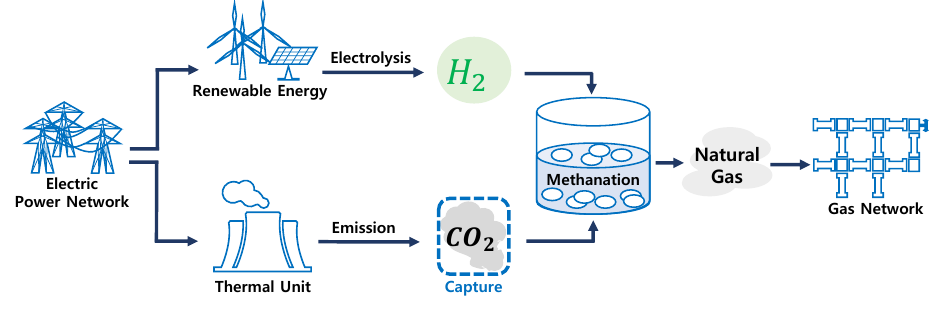
Figure 6. Concept of